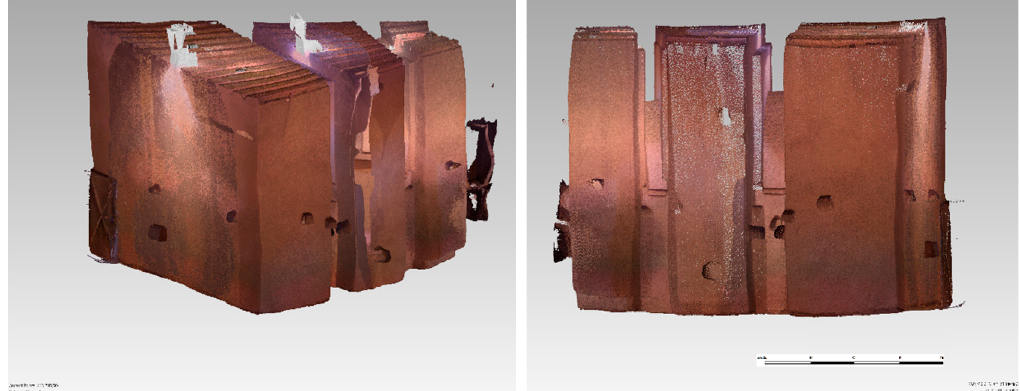
Figure 12. Textured point cloud from BLK360.